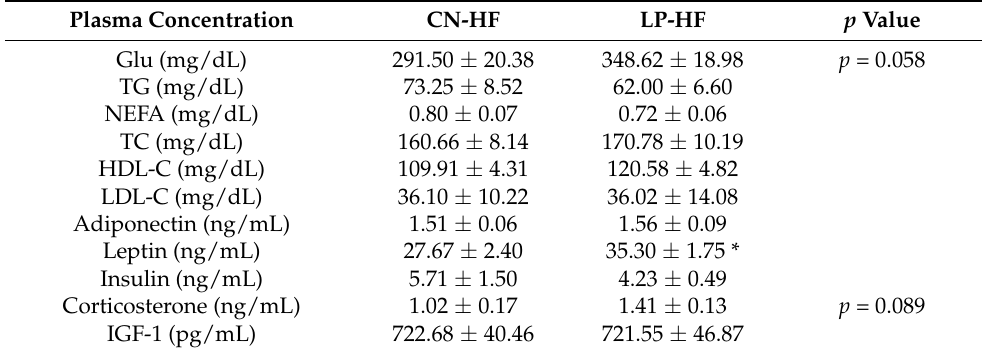
Figure 1. The effect of maternal low protein and post-weaning high-fat diet (HFD) intake on the offspring. ( a ) Body weight changes while the offspring were given HF diet; ( b ) Food intake from 6–32 weeks; ( c ) White fat weight, which contains mesenteric, epididymal, and retroperitoneal fat, at 32 weeks; ( d ) Mesenteric fat weight, ( e ) epididymal fat weight, and ( f ) retroperitoneal fat weight at 32 weeks. Measurement values were expressed as mean ± standard error (SE; n = 8/9). * p < 0.05 versus the CN-HF using Student’s t -test. CN-HF, maternal 20% casein offspring with HF group; LP-HF, maternal 9% casein offspring with HF group. Table 1. Plasma biochemical